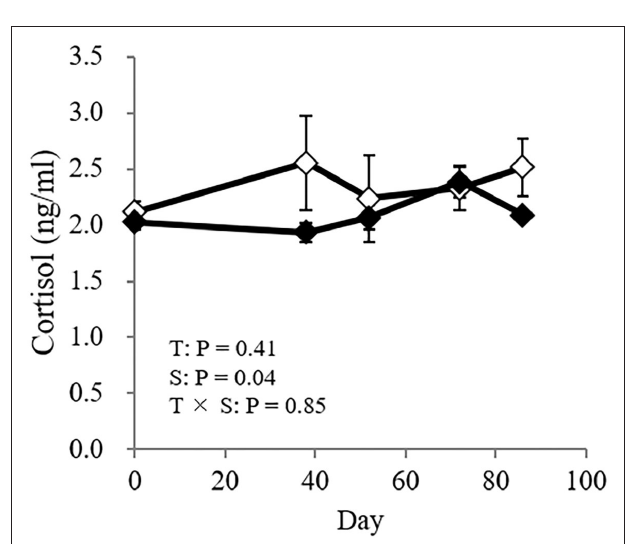
FIGURE 5 | The cortisol concentration in GCs ( (cid:7) ) and CCs ( ♦ ). The horizontal axis shows the day on which the blood sample for the cortisol analysis was obtained, and day 0 (0) represents the day the cattle were moved to a pasture. Data are presented as the means ± SEM. T, Treatment: a significant difference between treatments (GC vs. CC); S, sampling day: a significant difference between sampling days (0, 38, 52, 72, and 86); T × S = treatment × sampling day interaction: a significant difference in the interaction of treatment × sampling day. Differences were considered significant at P < 0.05. A tendency toward significance was indicated by 0.05 < P <